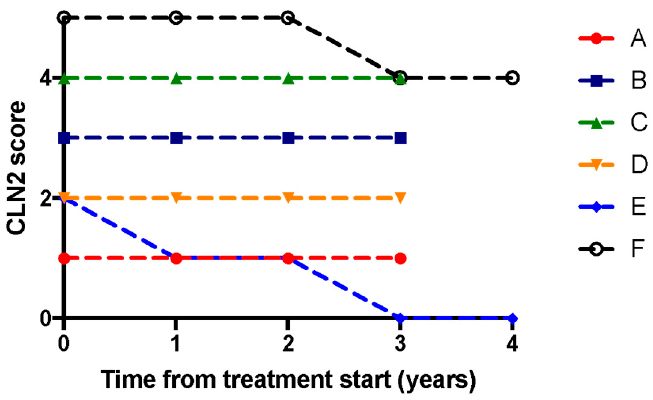
Figure 3. Change in CLN2 motor and language scores after treatment. Each of the six patients are represented individually (A-F, labelled in separate colours as per the legend). The dotted lines link the individual scores for each patient.